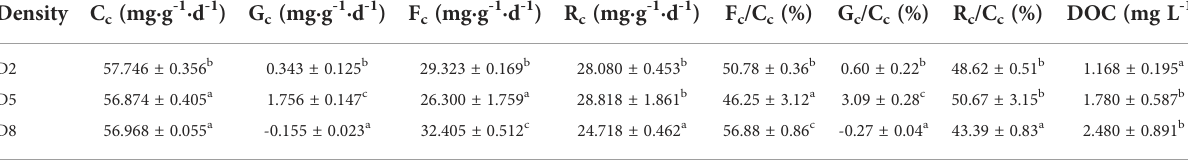
TABLE 4 Carbon parameters and carbon allocation into different physio-ecological processes in sea cucumber at different stocking densities.